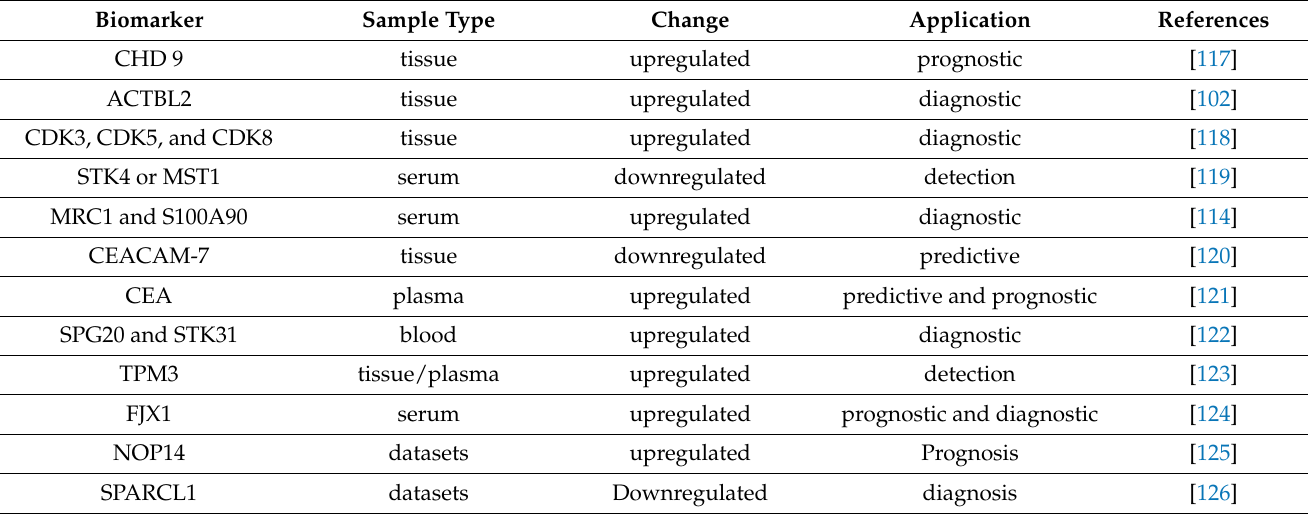
Table 3. Potential multi-omics based proteomics biomarkers in